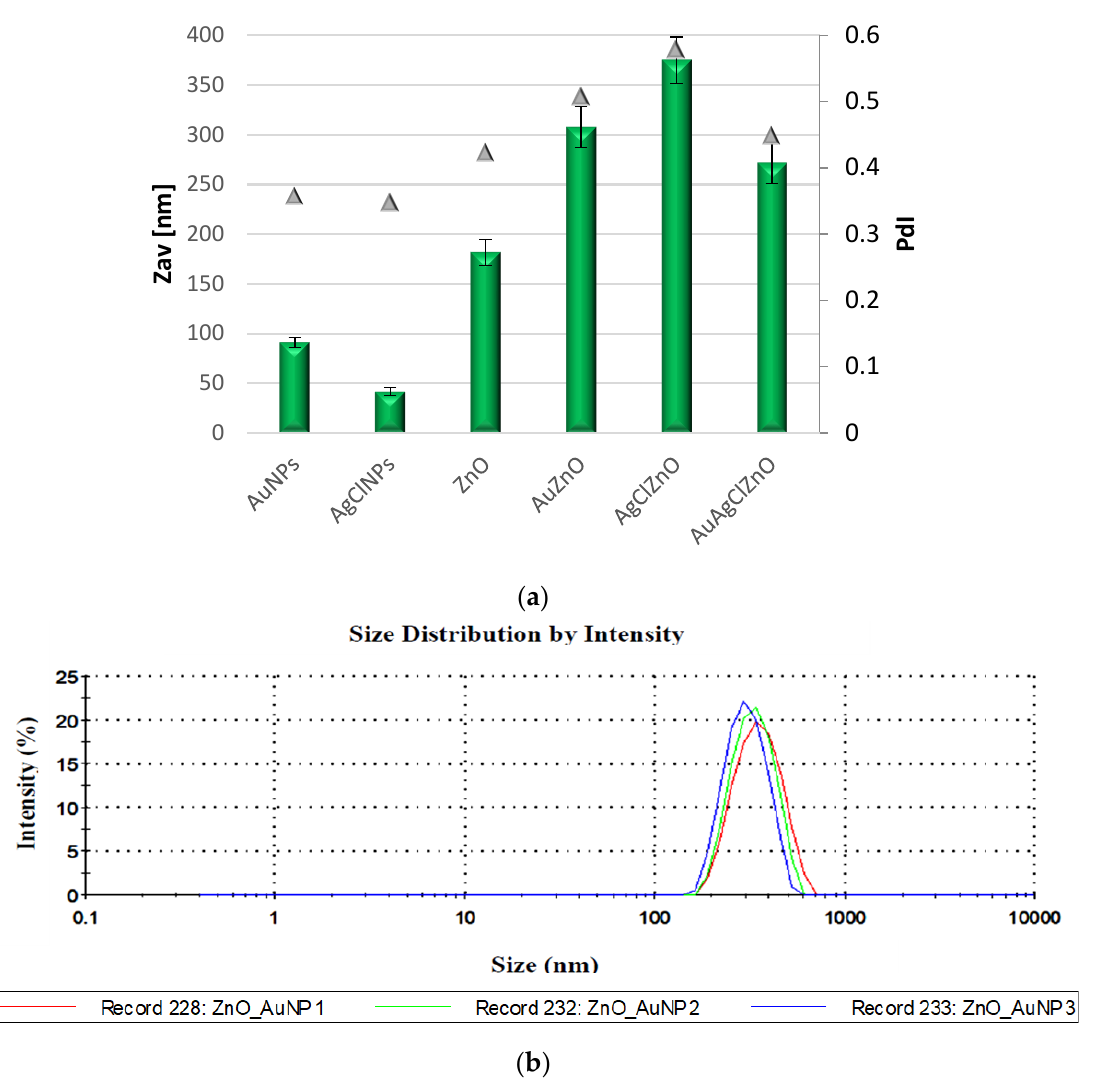
Figure 5. ( a ) The average particle size and PdI index of samples; ( b ) Size distribution of particles population for AuZnO sample.